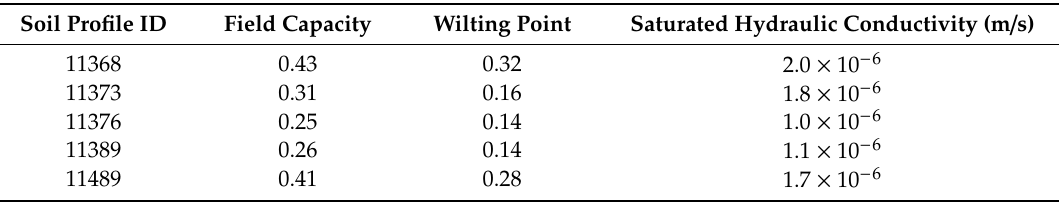
Table A2. The key soil physical parameters of subsoil